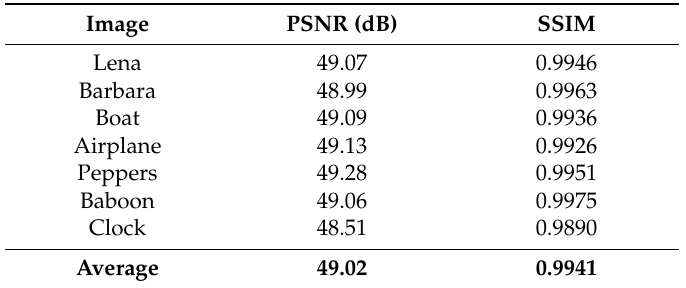
Figure 5. Watermarked images: ( a ) Lena; ( b ) Barbara; ( c ) Boat; ( d ) Airplane; ( e ) Peppers; ( f ) Baboon; ( g ) Clock. Table 2. Peak signal-to-noise ratio (PSNR) and SSIM values of the watermarked images.